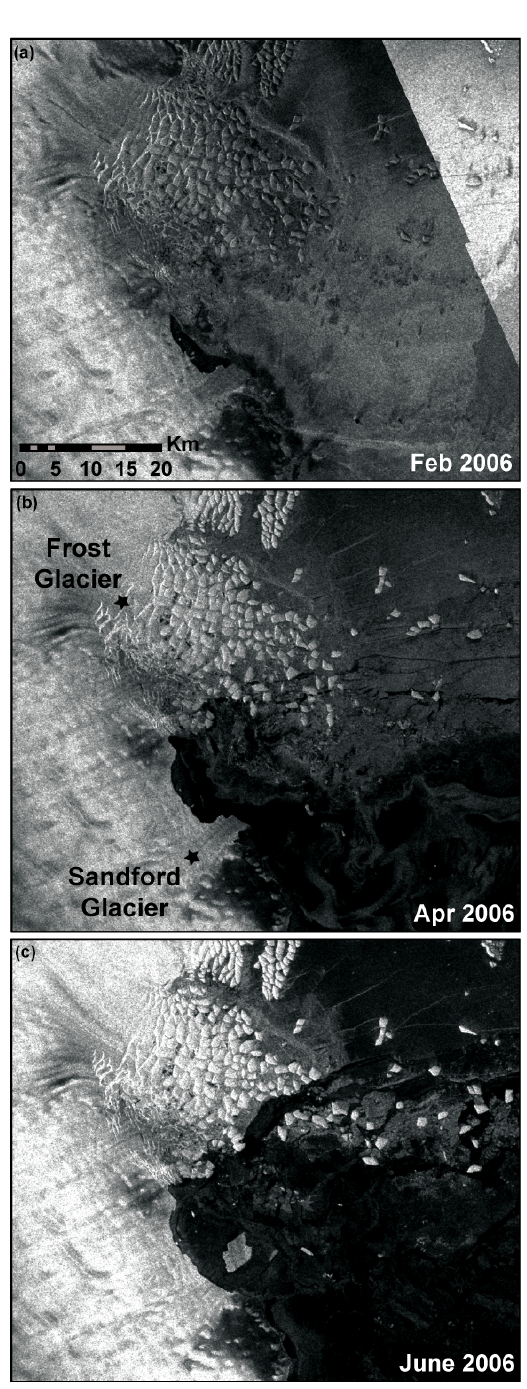
Figure 8. Time series of Frost and Sandford glaciers calving show- ing that sea ice clears prior to calving and dispersal of